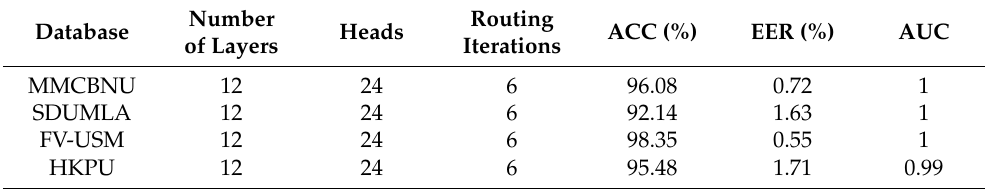
Table 3. Performance comparison of ViT-Cap with deep layers and routing iterations on four datasets.